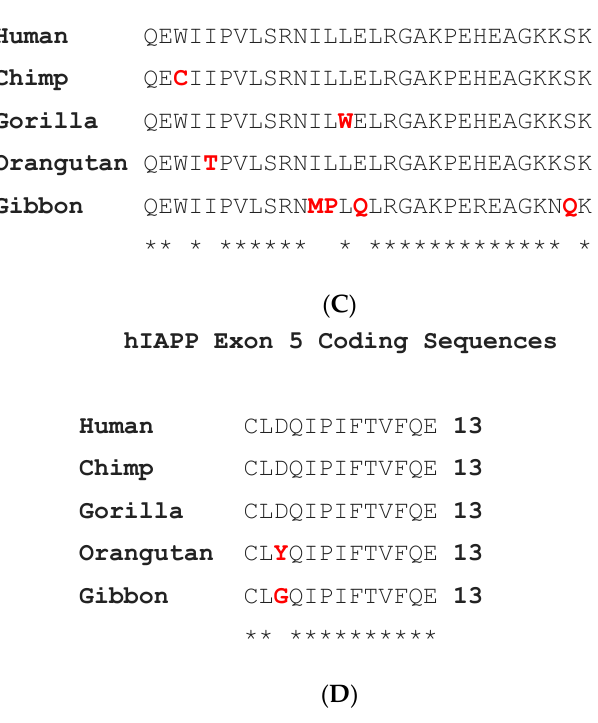
Figure 1. ( A ) Human IAPP gene structures and alternatively spliced isoforms. Open boxes represent exons, solid lines represent introns of different sizes in base pairs (bp) and P1 and P2 in circles are alternative promoters. Yellow boxes represent hominid-specific IAPP exons. Downward arrows and capital letters are at the intra-exonal splicing donor sites in exon 3 and alternative polyadenylation sites in exon 6. The red bars are exon junctional TaqMan probes that hybridize specifically to various IAPP isoforms. The spliced transcripts of hIAPP isoforms are named and below the gene structure. hIAPP-ex1 and -ex3a are not expressed and are expressed at low levels in islets, respectively. ( B ) Alignment of hIAPP α , hIAPP β , and hIAPP γ amino acid sequences. Homologous amino acids are marked by asterisks, signal peptide underlined by wavy lines, prohormone regions by gray highlight, the convertase dibasic amino acids by blue lettering, mature IAPP 37 by red lettering, bisulfide bond cysteine ( C ) by purple lettering, IAPP 25 by yellow highlight, the proteolytic peptide names by green lettering, and the sequences are bolded and underlined. Exon numbers are above the sequences and demarcated by the | sign. ( C ) Alignment of exon 4 of the hIAPP γ CDS. ( D ) Alignment of exon 5 of the hIAPP β CDS. The amino acids coded by nonsynonymous substitutions are shown in red lettering.